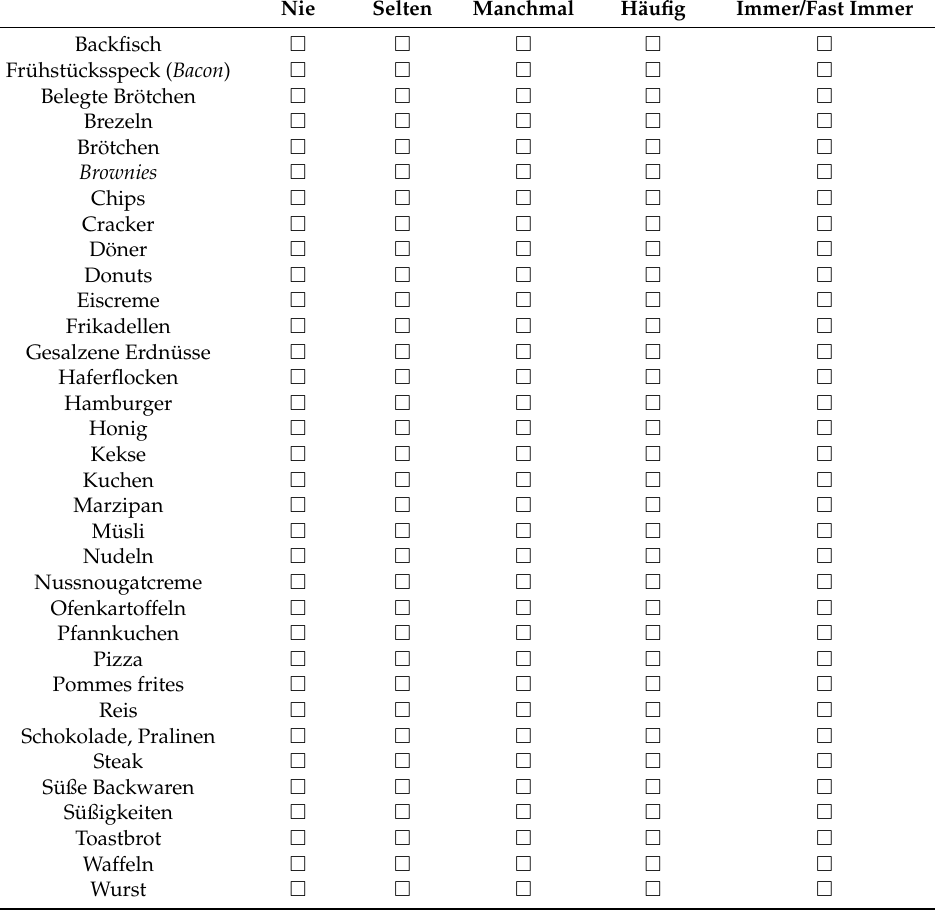
Table A1. List of foods and frequency to which they are